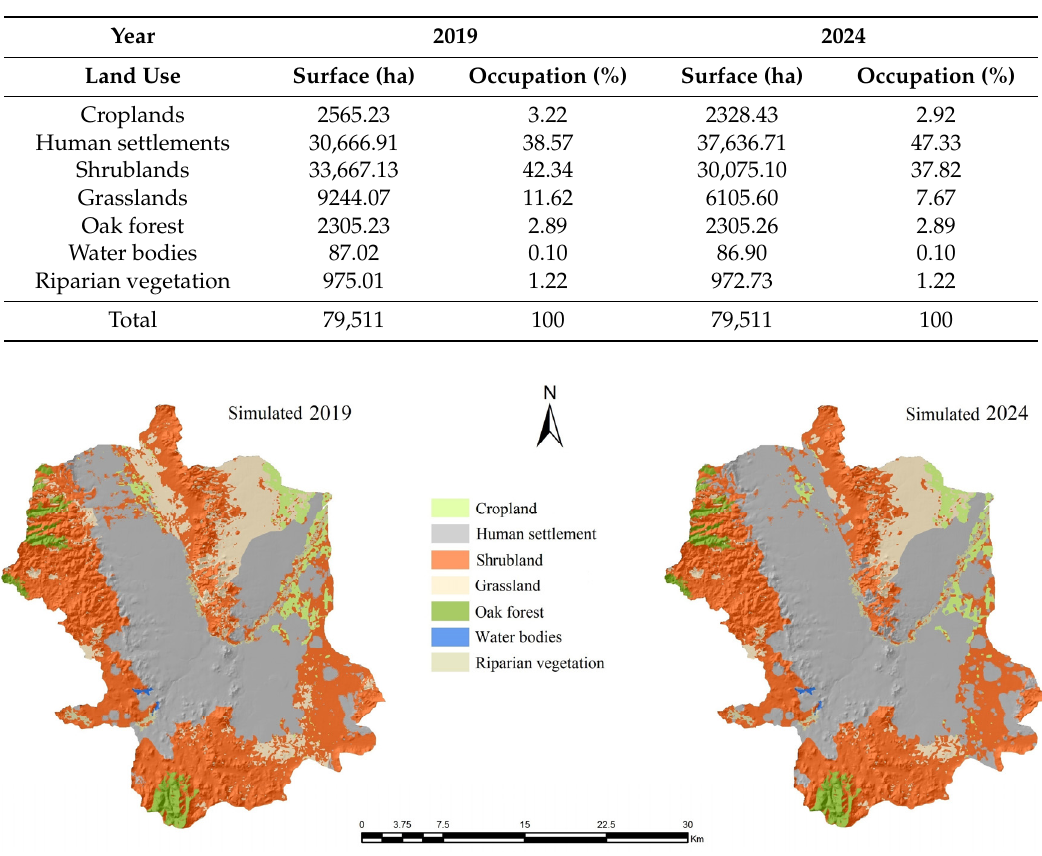
Figure 10. Simulated occupied areas of seven land uses of the urban and peripheral areas of Chihuahua City by 2019 and 2024. City by 2019 and 2024.